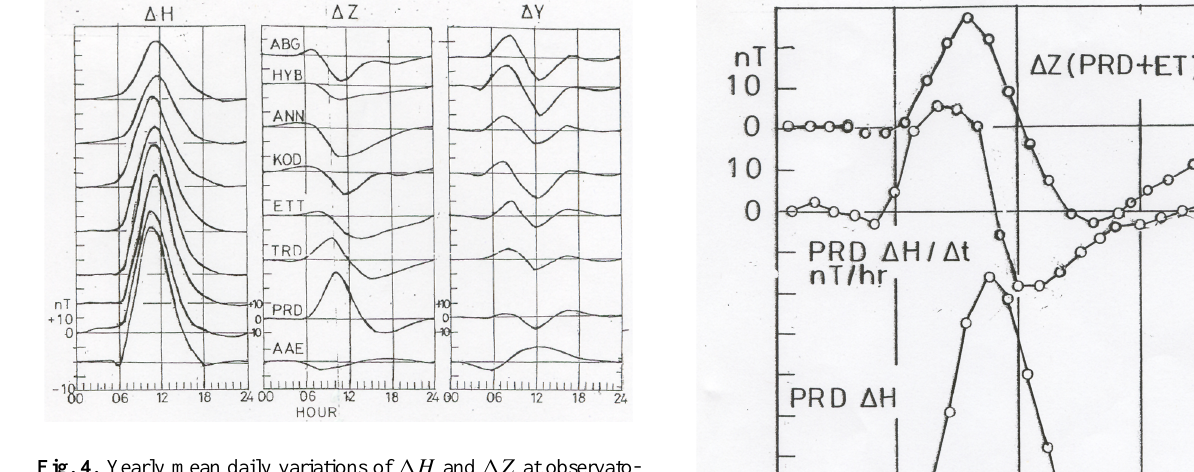
Fig. 4. Yearly mean daily variations of 1H and 1Z at observato- ries along Indo-Sri Lanka longitude sector during the period March 1993–February 1994.